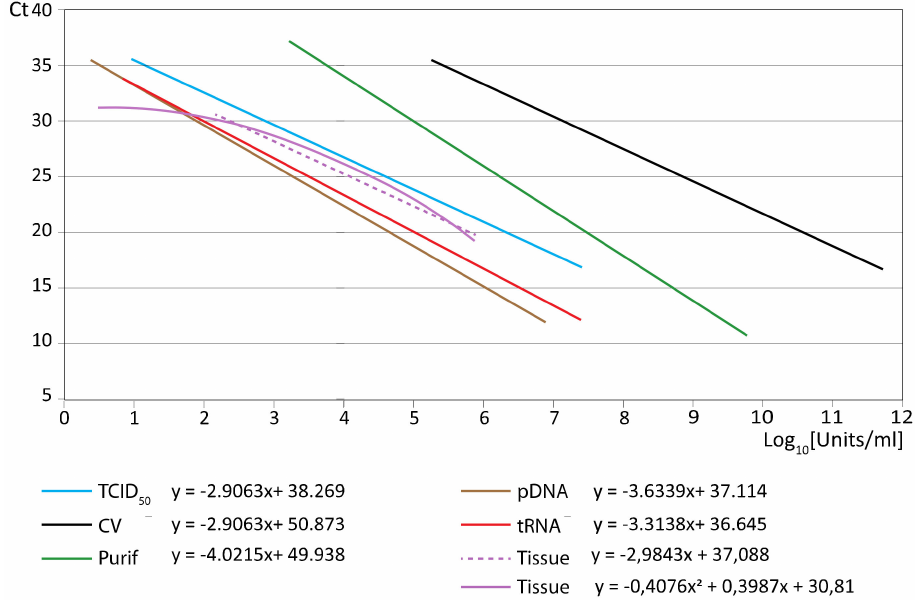
Figure 2. Comparison of standard curves. The regression lines with each type of standard averaging the data from the 4 strain types assessed are